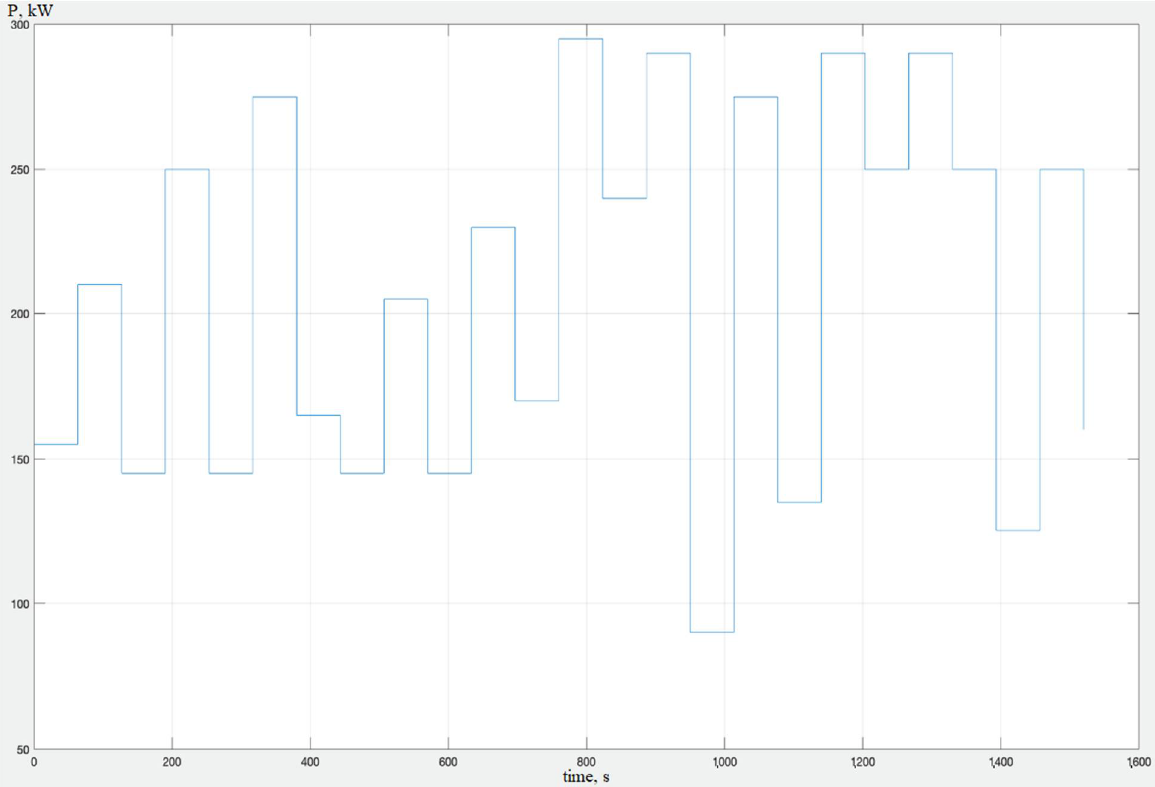
Figure 2. Fragment of the curve of active power consumption with a VFD. Figure 4. Fragment of the curve of active power consumption with a